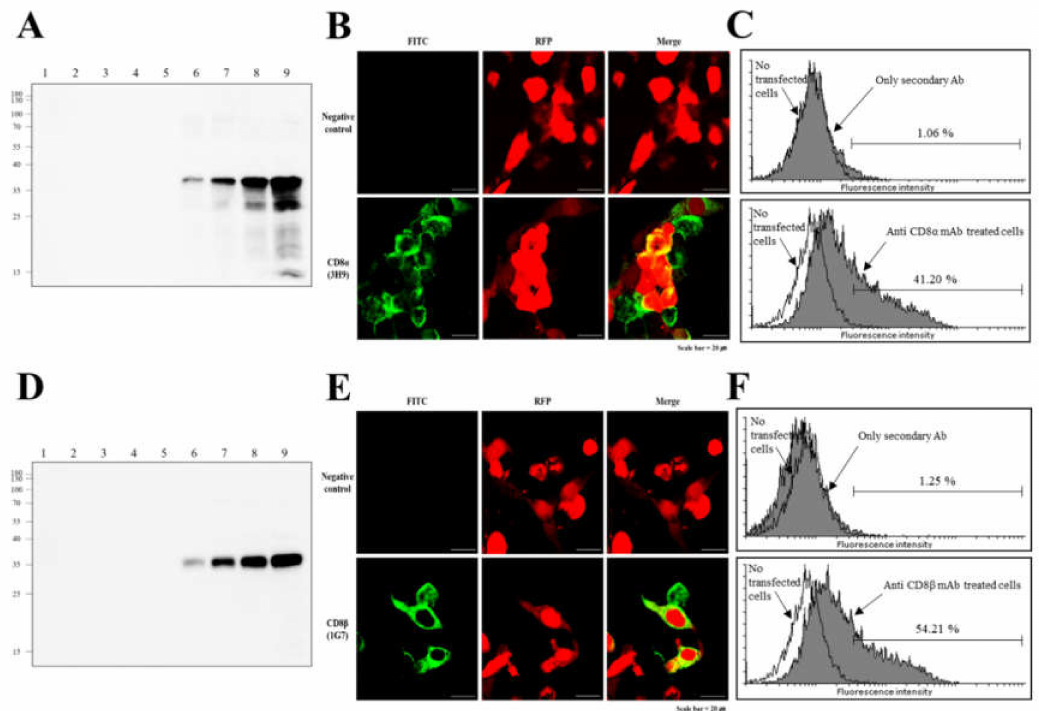
Figure 3. Reactivity of anti-CD8 α mAb and anti-CD8 β mAb to transfected HEK 293F cells stably expressing flounder CD8 α and CD8 β molecules. ( A ) The antibody was screened for specificity against increasing amounts of recombinant CD8 α . Lanes:(1), rCD4-1 at 500 ng; (2), rCD4-2 at 500 ng; (3), rCD8 β at 500 ng; (4), rCD8 α at 16 ng; (5), rCD8 α at 32 ng; (6), rCD8 α at 63 ng; (7), rCD8 α at 125 ng; (8), rCD8 α at 250 ng; (9), rCD8 α at 500 ng. ( B ) Immunofluorescence staining of CD8 α -positive HEK 293F cells, with the anti-CD8 α mAb (3H9), showing the CD8 α molecule located on the surface of the cells, Scale bar = 20 um. ( C ) Compared with the populations of cells expressing the CD8 α molecule, a number of cells (~39%) showed reaction to anti-CD8 α mAb (3H9), and only ~2% of cells were observed in the negative controls. ( D ) The antibody was screened for sensitivity against increasing amounts of recombinant CD8 β . Lanes:(1), rCD4-1 at 500 ng; (2), rCD4-2 at 500 ng; (3), rCD8 α at 500 ng; (4), rCD8 β at 16 ng; (5), rCD8 β at 32 ng; (6), rCD8 β at 63 ng; (7), rCD8 β at 125 ng; (8), rCD8 β at 250 ng; (9), rCD8 β at 500 ng.( E ) Immunofluorescence staining of CD8 β -positive HEK 293F cells, with the anti-CD8 β mAb (1G7), Scale bar = 20 um. ( F ) Numerous cells (~40%) reacted with anti-CD8 β mAb (1G7), and only ~2% of cells were observed in the negative